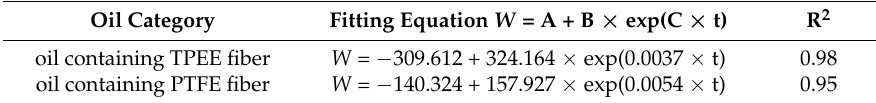
Table 1. Fitting relations between the water contents and aging